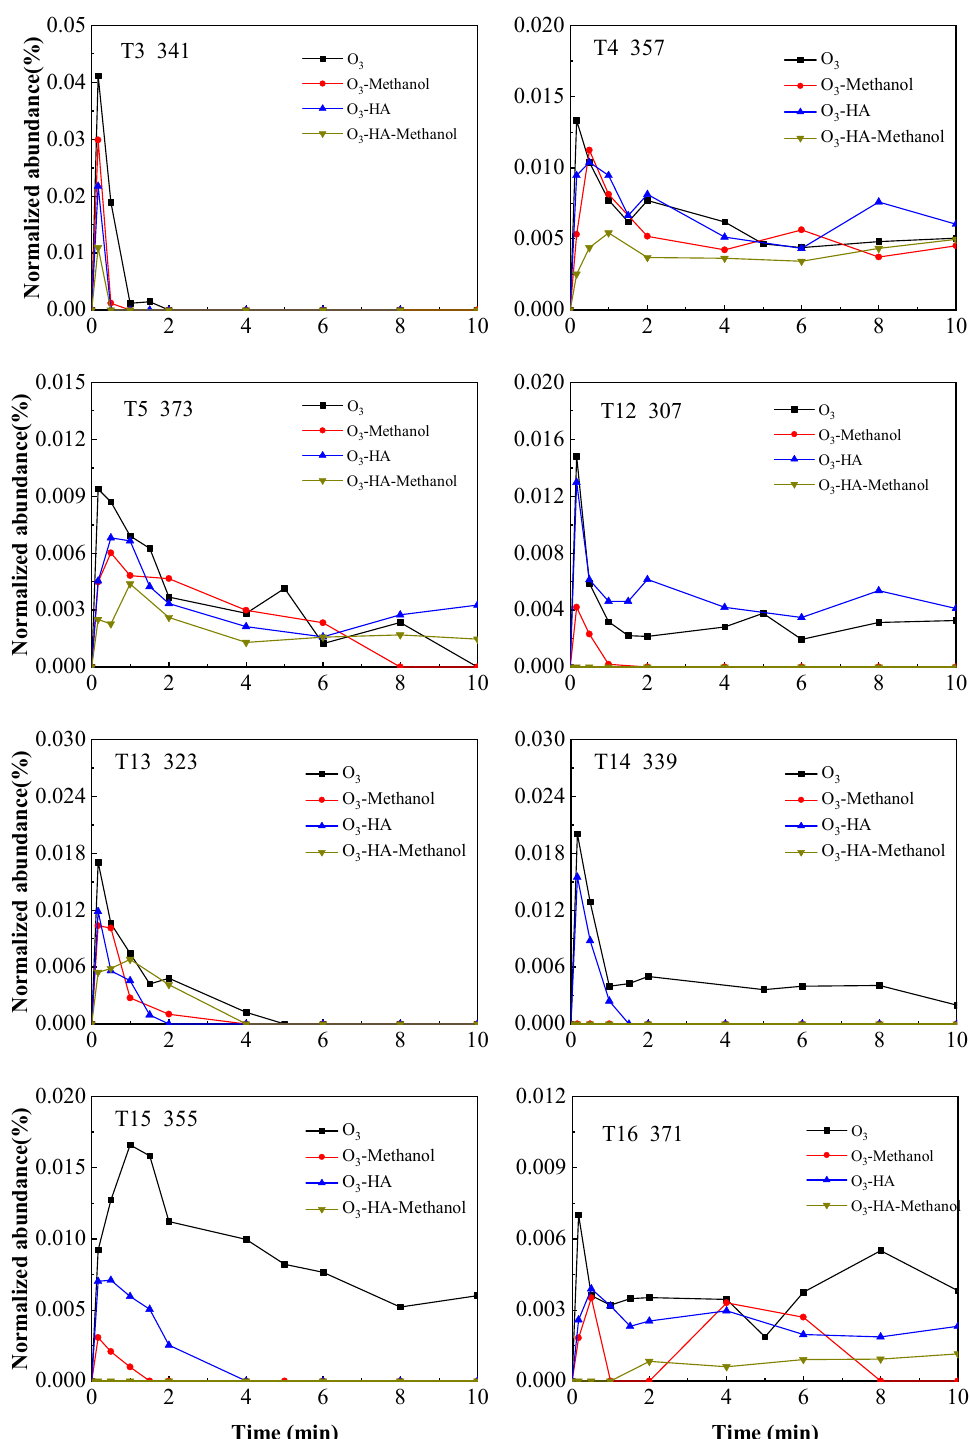
Figure5. FormationofhydroxylationproductsduringTMPozonation(initialTMP concentration = 10 mg / L, Figure 5. Formation of hydroxylation products during TMP ozonation (initial TMP concentration = initial pH = 6.0 ± 0.1, 20 ◦ 10 mg/L, initial pH = 6.0 ± 0.1, 20°C).